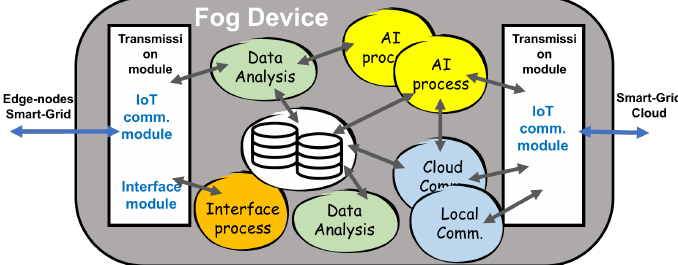
Figure 4. Relationship between the modules in a fog node device according to the established